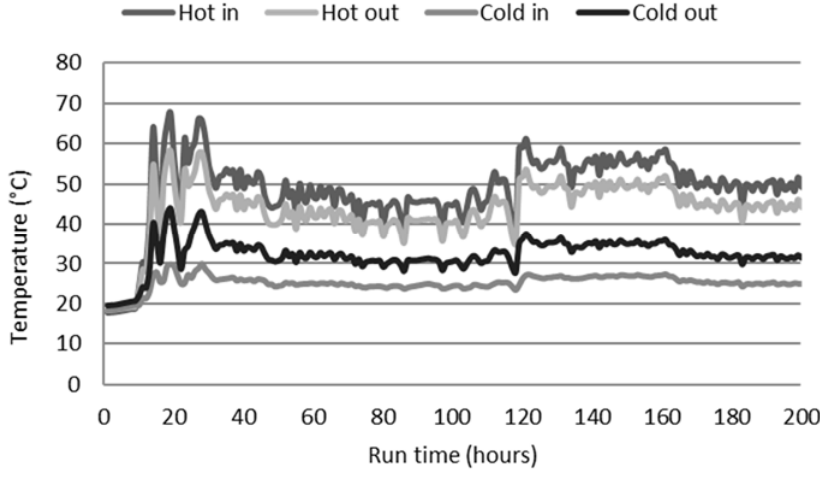
Figure 6. Temperature profile using the standard hydrophobic membrane.